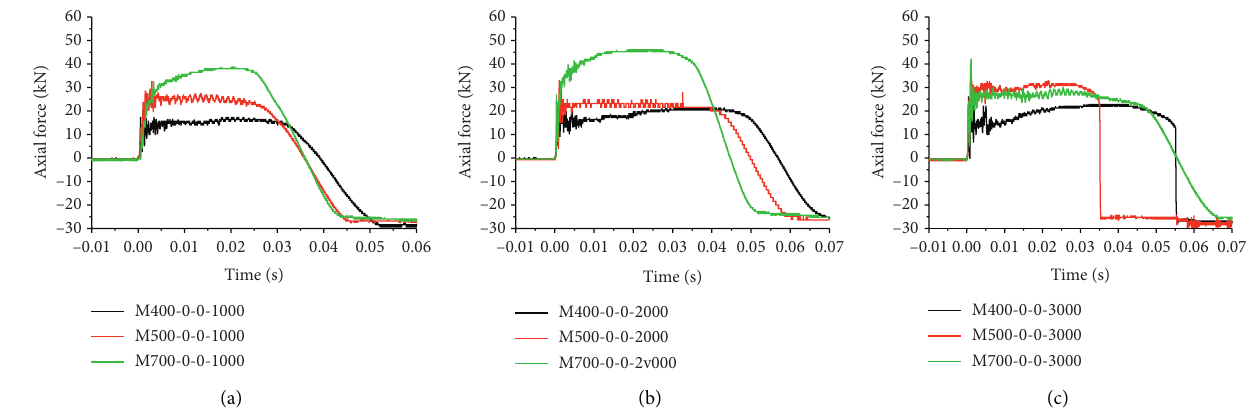
Figure 6: Time-history curves of the axial force of different material bolts in the bolted